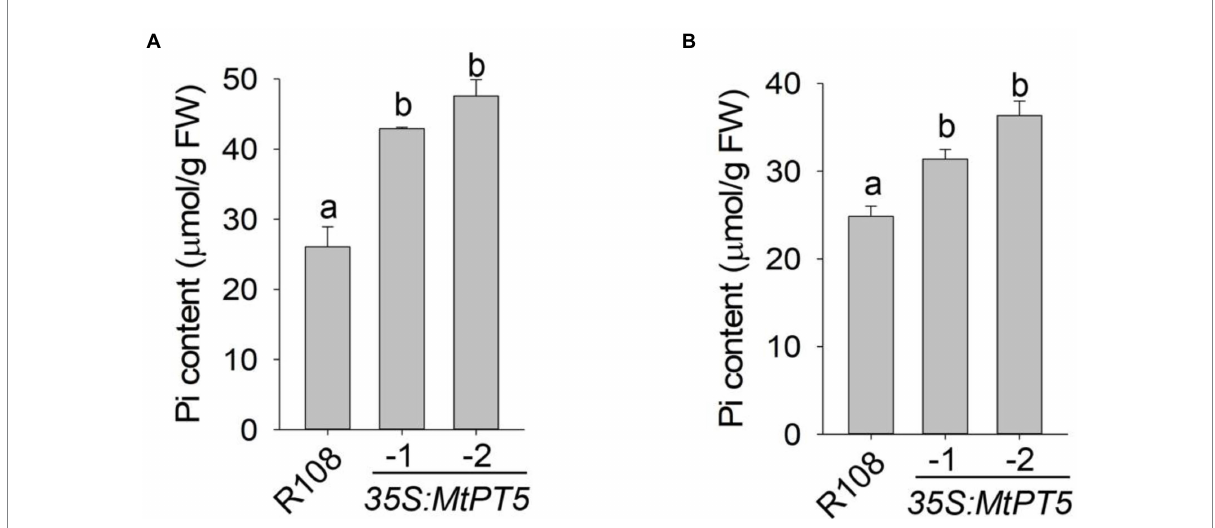
FIGURE 5 Overexpression of MtPT5 enhances Pi accumulation of M. truncatula. (A) Pi content in top leaflets of wild type (R108) and MtPT5- overexpressing plants grown in soil for 3 months. Data represent mean ± SE ( n = 3). Different letters indicate significant difference at p < 0.05 (One-way ANOVA, Tukey test). (B) Pi content of wild type (R108) and 35S:MtPT5 -overexpressing plants. Four-day-old seedlings were transferred to 1/2 Hoagland and grown for 20 days, then the whole plants were taken for Pi extraction. Data represent mean ± SE ( n = 5). Different letters indicate significant difference at p < 0.05 (One-way ANOVA, Tukey